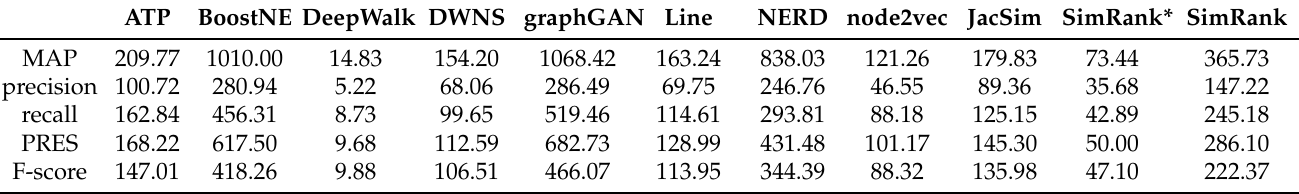
Table 5. Accuracy improvements (%) by NetMF over other methods with the BlogCatalog dataset.